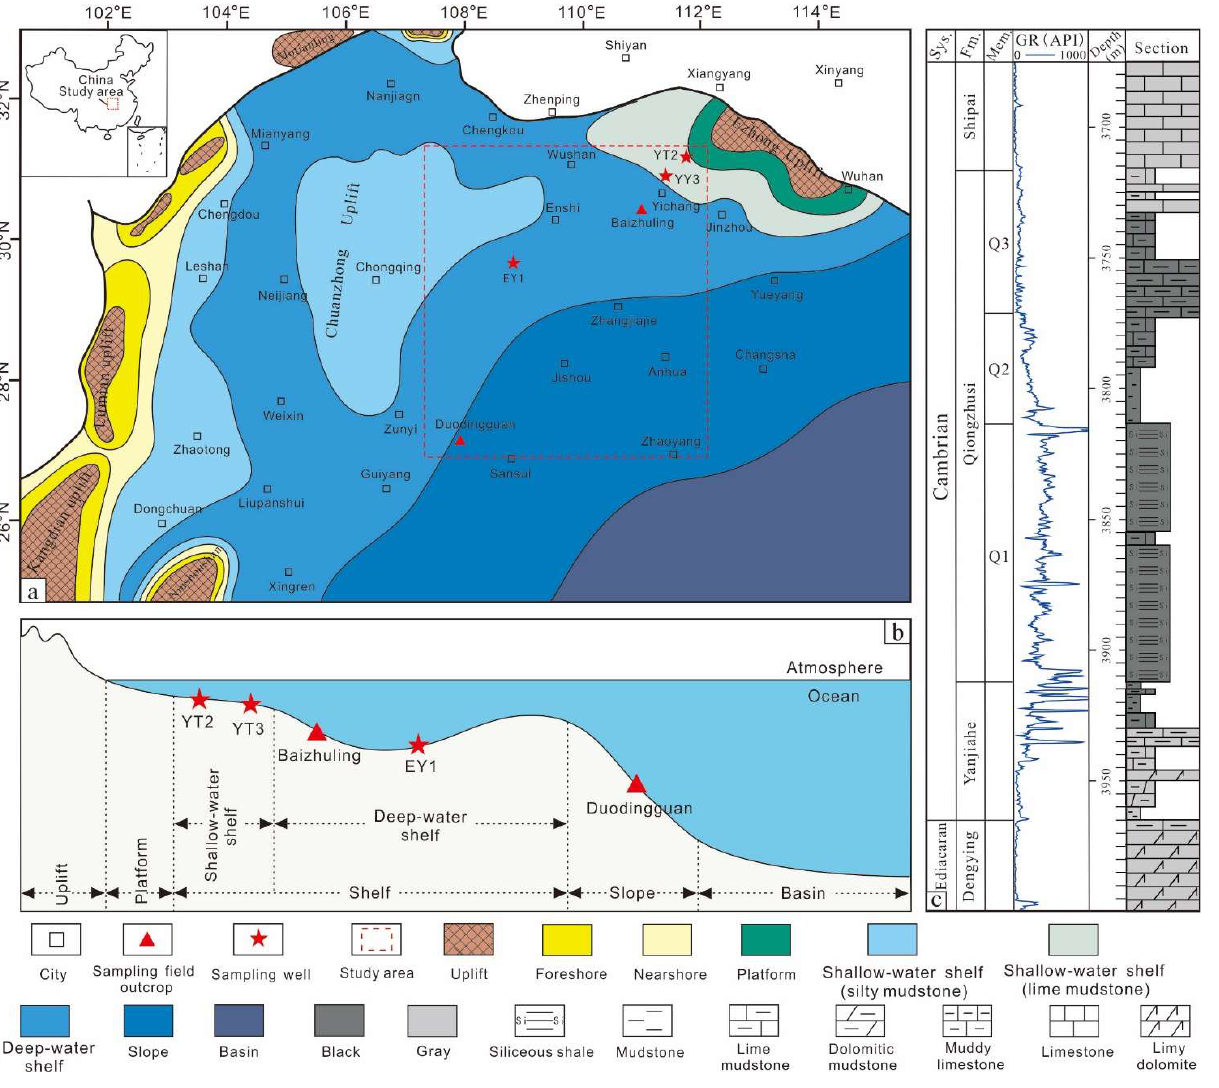
Figure 1. ( a ) Map showing the location of the study area and the lithofacies of the Early Cambrian Qiongzhusi Formation in the middle and upper Yangzi region in southern China (adapted from [31]); ( b ) NE-SW cross-section of the Qiongzhusi Formation in the study area from the ancient land to the deep-water basin; and ( c ) stratigraphic histogram of the Qiongzhusi Formation in the study area (in well EY1).